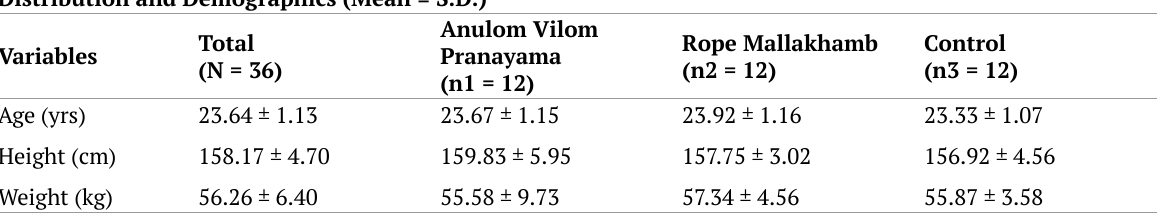
Figure 1. Study flow Table 1. Distribution and demographics of subjects. Distribution and Demographics (Mean ± S.D.)